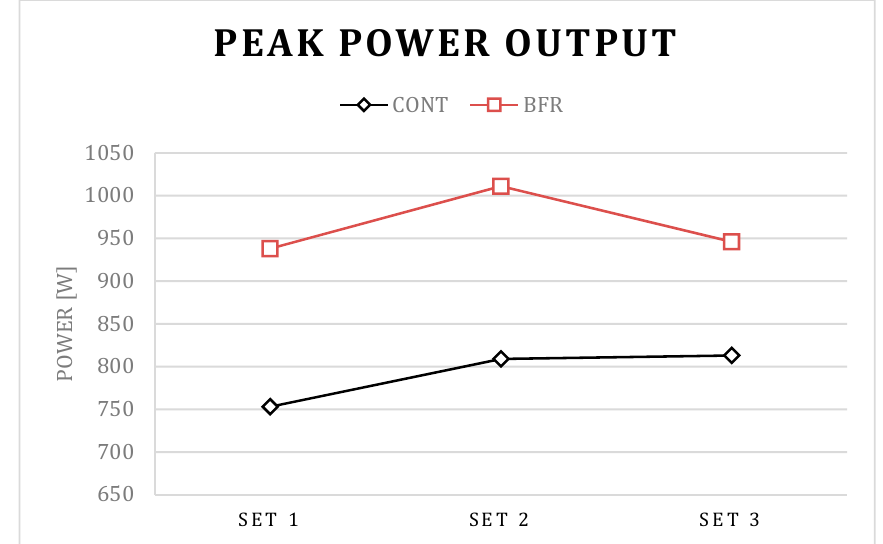
Figure 1. Mean power output for the BFR and CONT conditions during three successive sets of the bench press exercise.